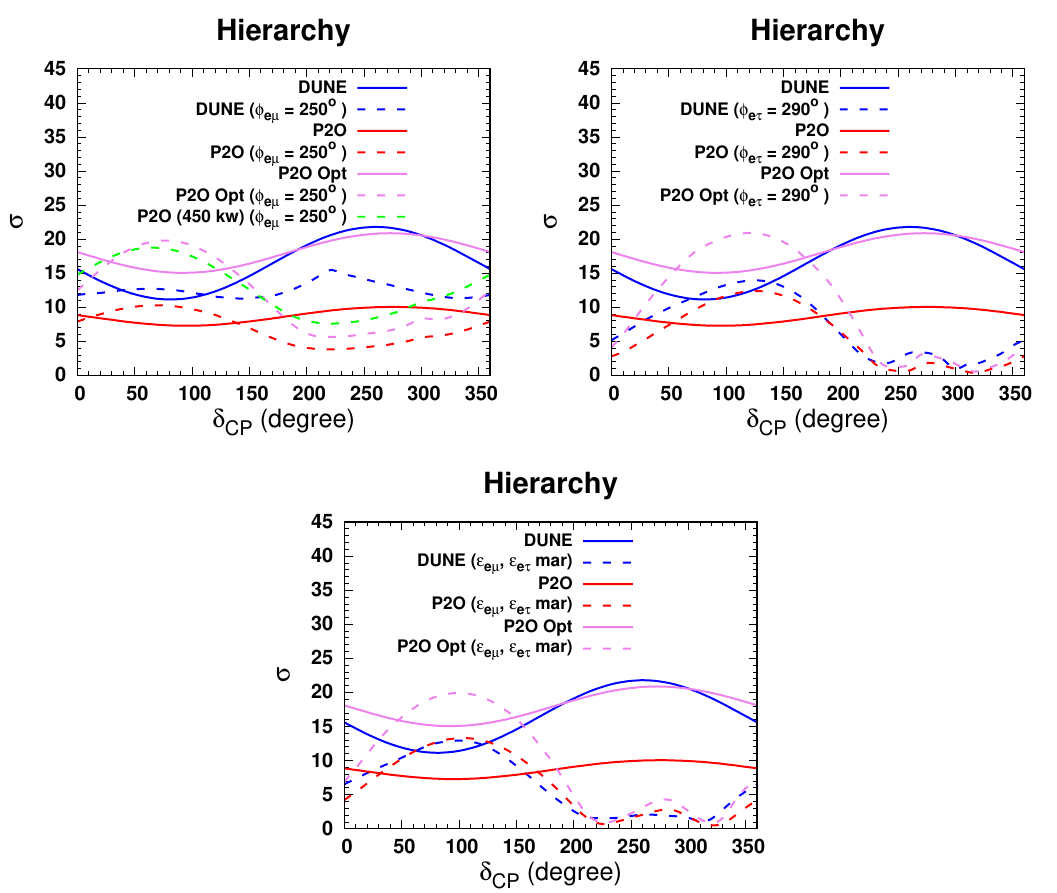
Figure 5 . Hierarchy sensitivity as a function of δ CP (true) in presence of NSI. The top left (right) panel is for only (cid:15) eµ ( (cid:15) eτ ). The bottom panel is when both (cid:15) eµ and (cid:15) eτ are included in the analysis. These panels are generated for true normal